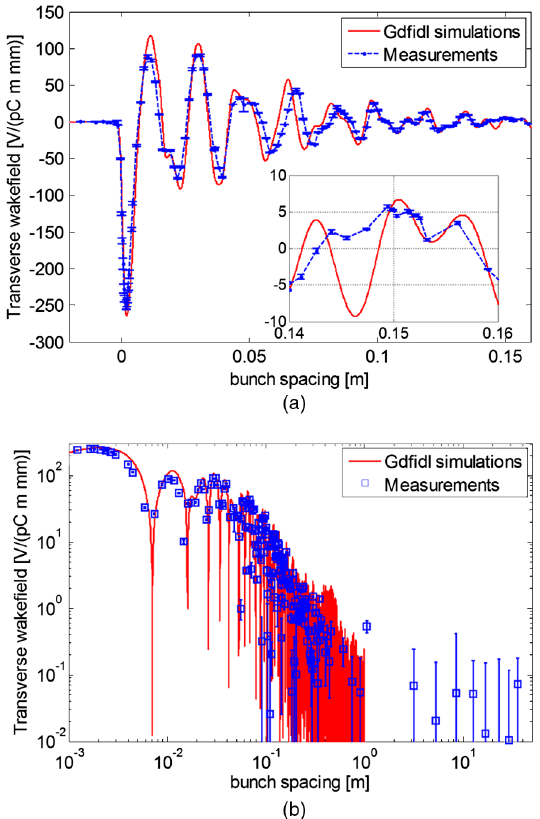
FIG. 6. Measured time-depended wakefield: (a) partial data (linear scale); (b) full data (log